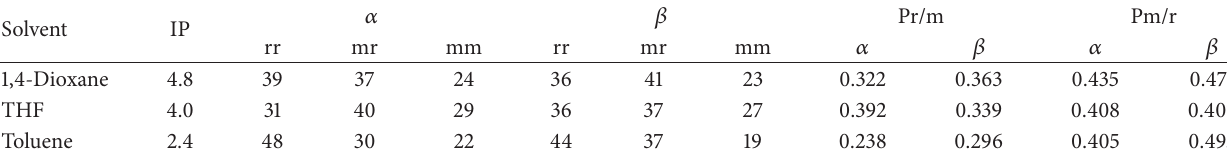
Table 4: Evolution of poly(NMNVA) tacticity.